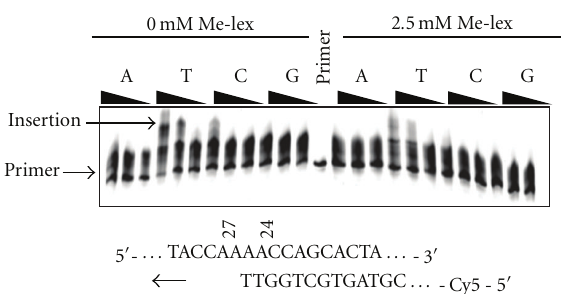
Figure 5: Insertion opposite 3-mA by T7 Sequenase. The template strand was treated with Me-lex as described in Figure 1. A 5 (cid:2) -Cy5- primer (Table 1, P25) was added that overlaps with the two A’s (A24, A25) that are not methylated by Me-lex. T7 Sequenase was added and the reactions initiated by the addition of 5, 50 or 500 μ M concentration of the individual dNTPs at 37 ◦ C. The insertion of T is inhibited in the 2.5 mM Me-lex treated DNA versus the untreated DNA (0 Me-lex). There is no indication that G, T or C is inserted opposite the